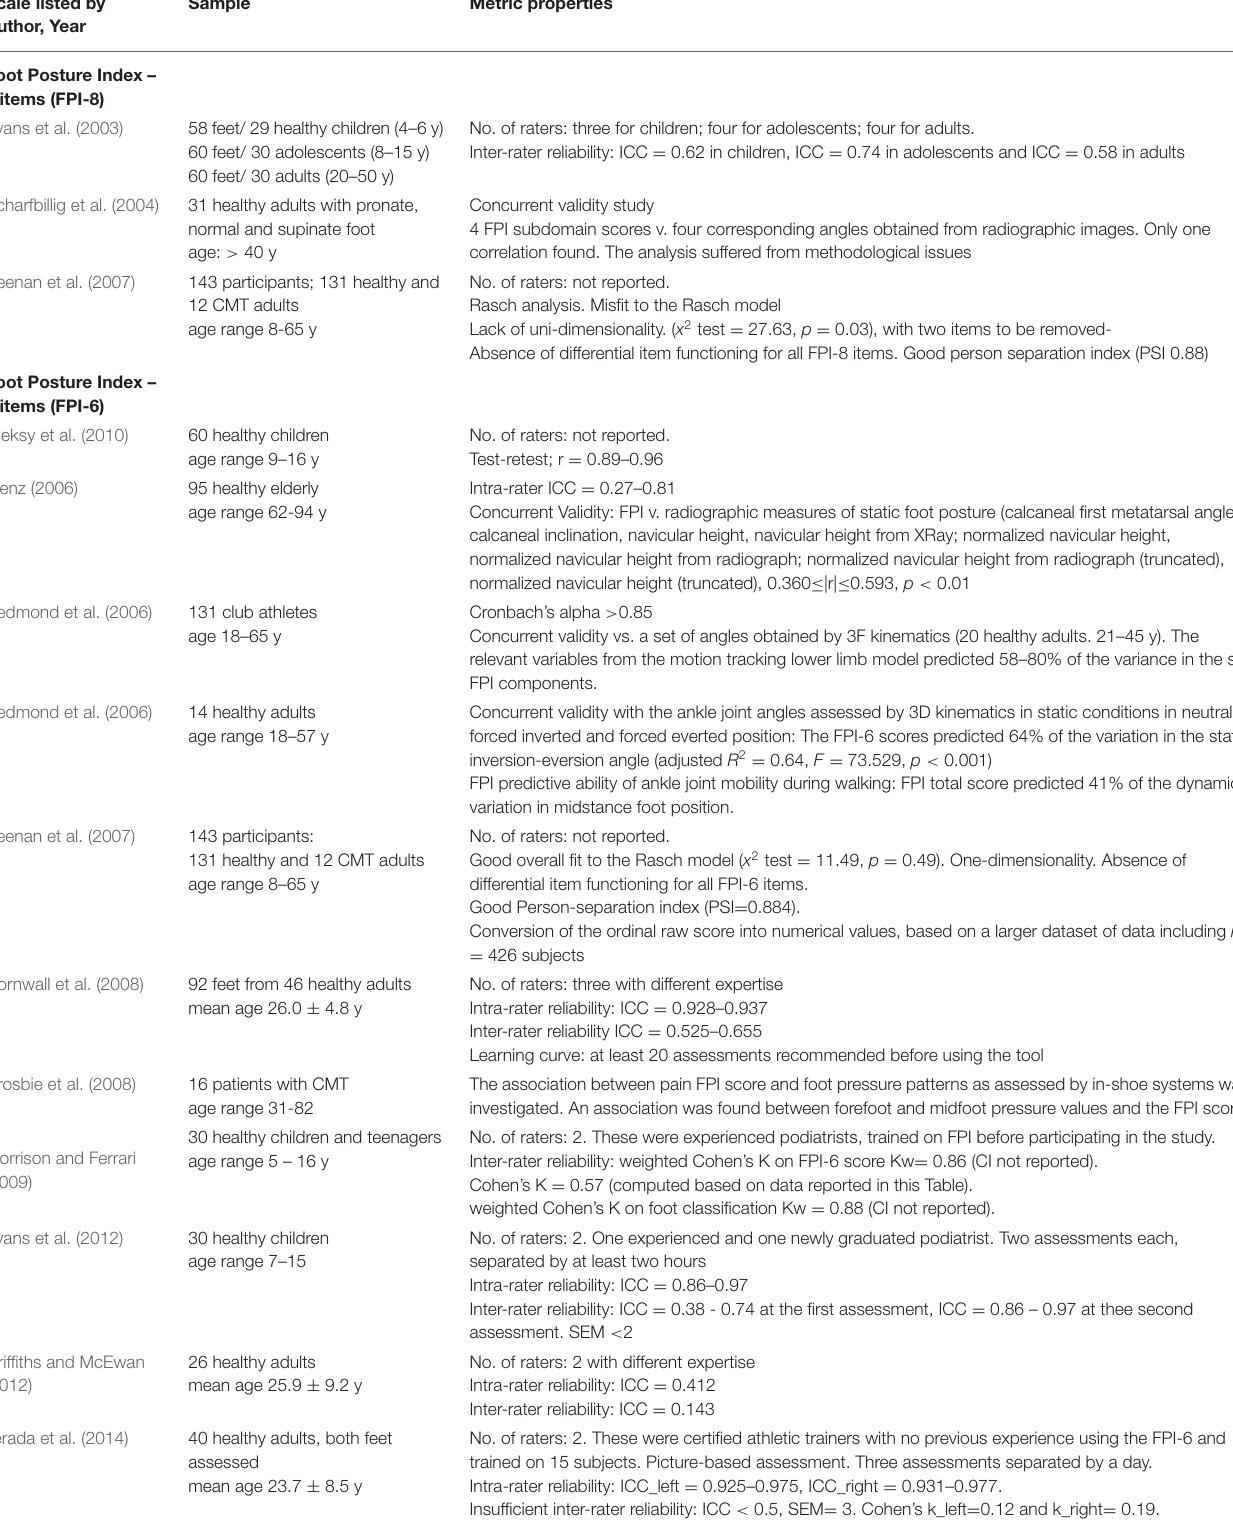
TABLE 2 | Sample characteristics and metric properties of the scales as reported in all studies